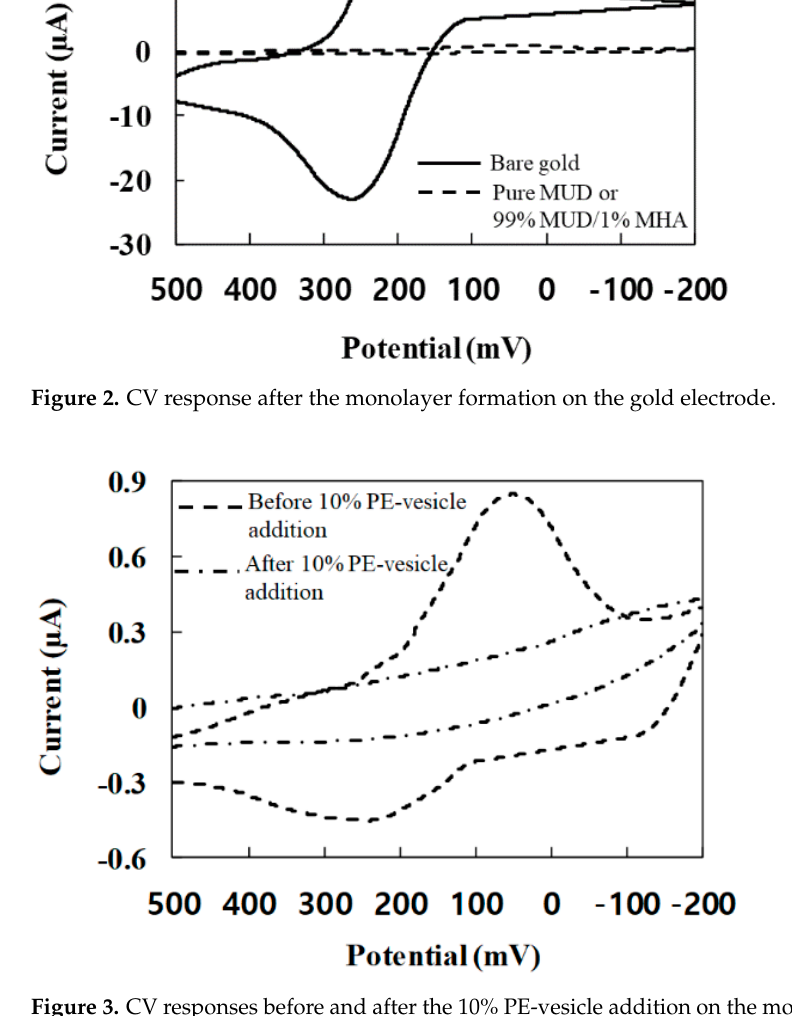
Figure 2. CV response after the monolayer formation on the gold electrode.